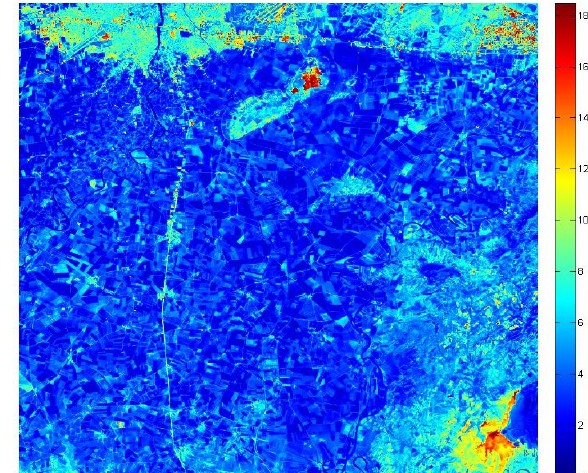
Figure 6. Soil Heat Flux Map (W/m 2 )